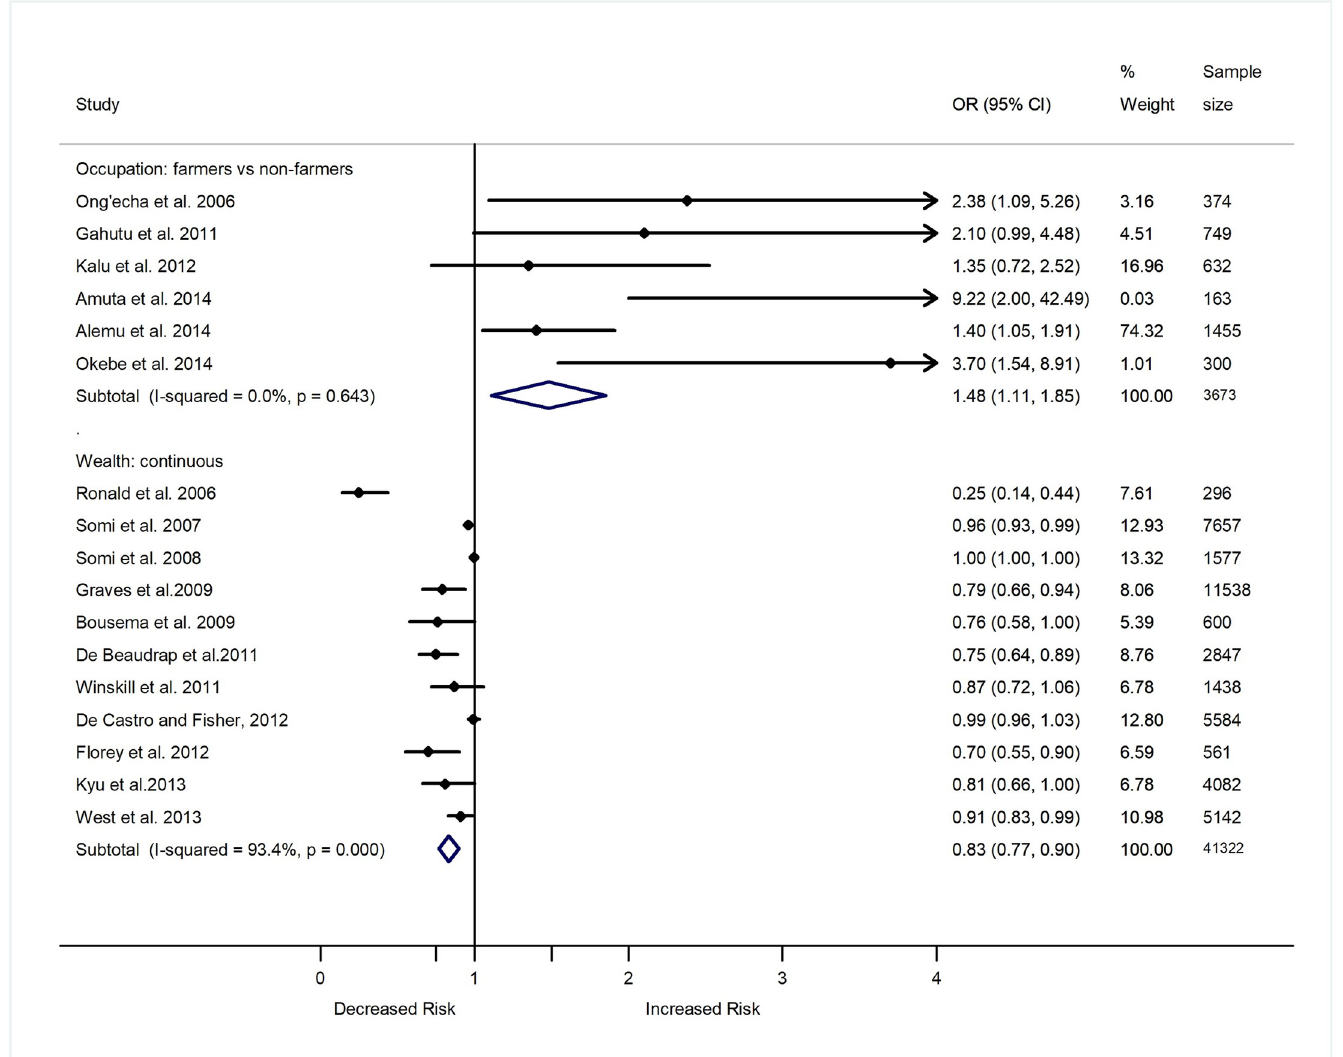
Fig 6. Forest plot showing the relationship of wealth and occupation with the epidemiology of malaria in sub-Saharan Africa. Wealth was treated as continuous and occupation was treated as a categorical variable. Values show the odds ratio of Plasmodium infection (95% CI). Total (summary) ORs estimated using random effect model. Weights estimated using inverse variance method. I-Squared, a measure of